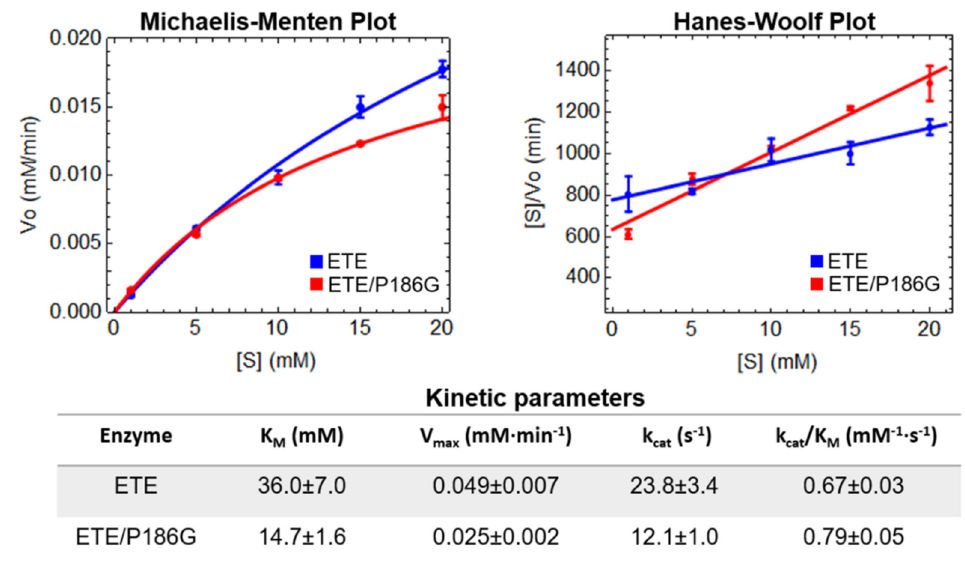
Figure 3. Determination of ETE and ETE/P186G kinetic parameters. The upper panels show the Michaelis–Menten and Hanes–Woolf plots for both enzymes. The table in the lower panel contains the values for the kinetic parameters estimated from the Hanes–Woolf plots through linear regression. V o , [S], K M , V max and k cat stand for initial velocity, substrate concentration, Michaelis constant, maximal velocity and catalytic constant, respectively. The k cat /K M ratio quantifies the catalytic efficiency of each enzyme. Mean values ± standard errors of the mean are shown in all cases.